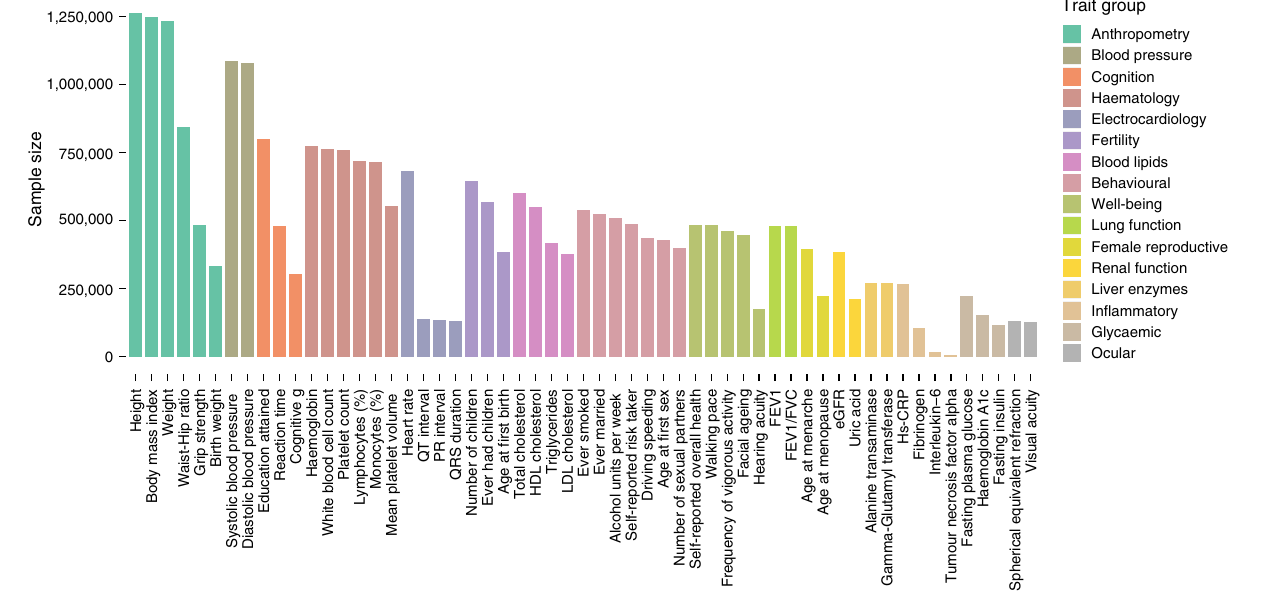
Fig. 1 Census of complex traits. Sample sizes are given for analyses of 57 representative phenotypes, arranged into 16 groups covering major organ systems and disease risk factors. HDL high-density lipoprotein, LDL low-density lipoprotein, hs-CRP high-sensitivity C-reactive protein, TNF-alpha tumour necrosis factor alpha, FEV1 forced expiratory volume in one second, FVC forced vital capacity, eGFR estimated glomerular fi ltration